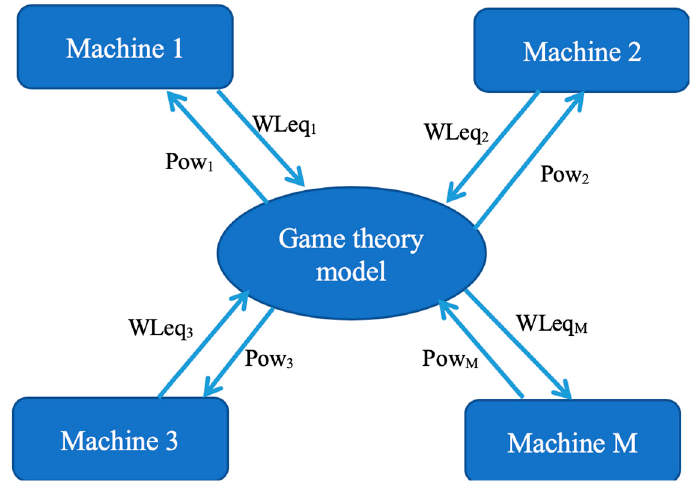
Figure 1. Game Theory Model.